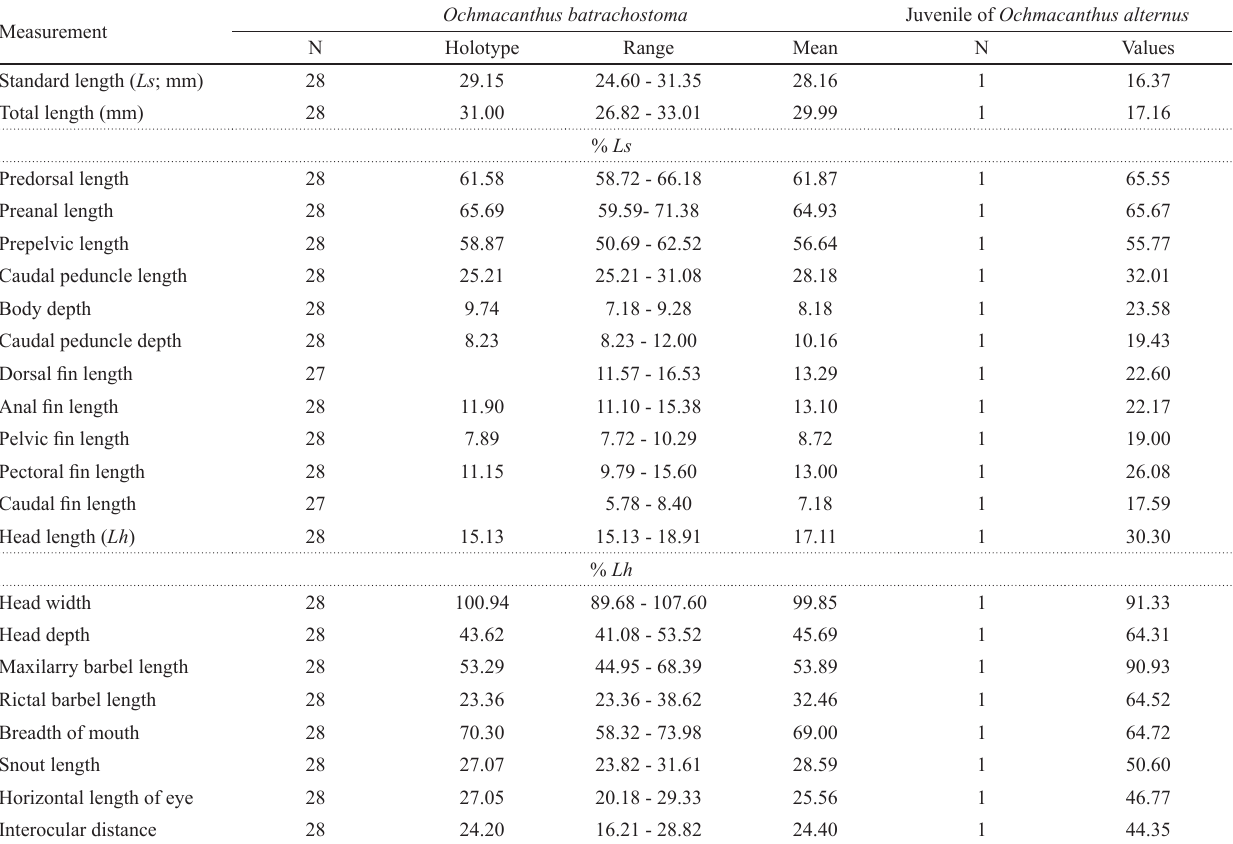
Table 1. Morphometrics of Ochmacanthus batrachostoma and a juvenile of O. alternus, FMNH 99611 . Range values of O. batrachostoma are for holotype and non-type